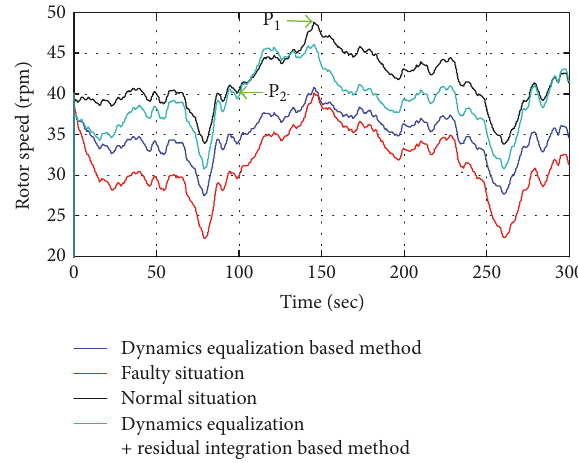
Figure 10: The rotor speed in the normal, faulty, and fault tolerant situation.